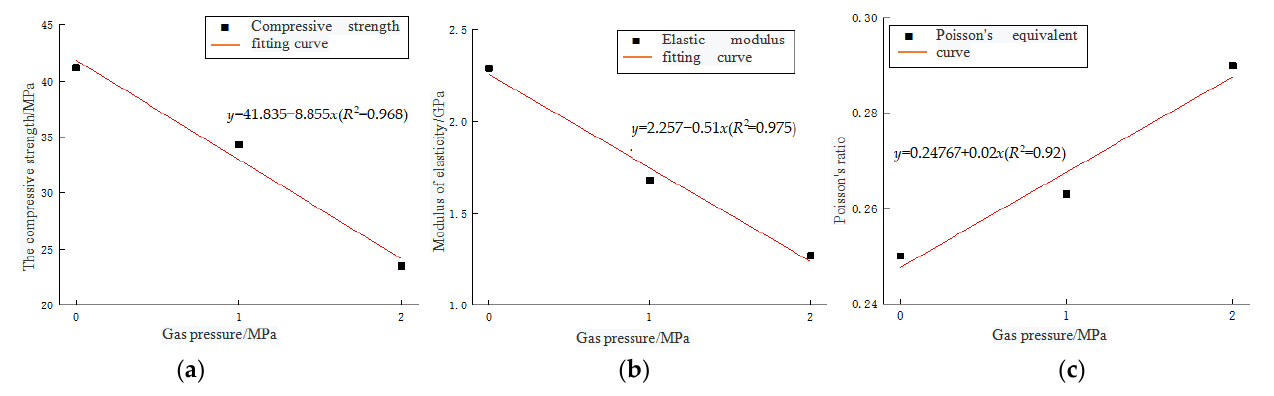
Figure 4. Fitting curves of the mechanical properties of coal samples under different gas pressures.